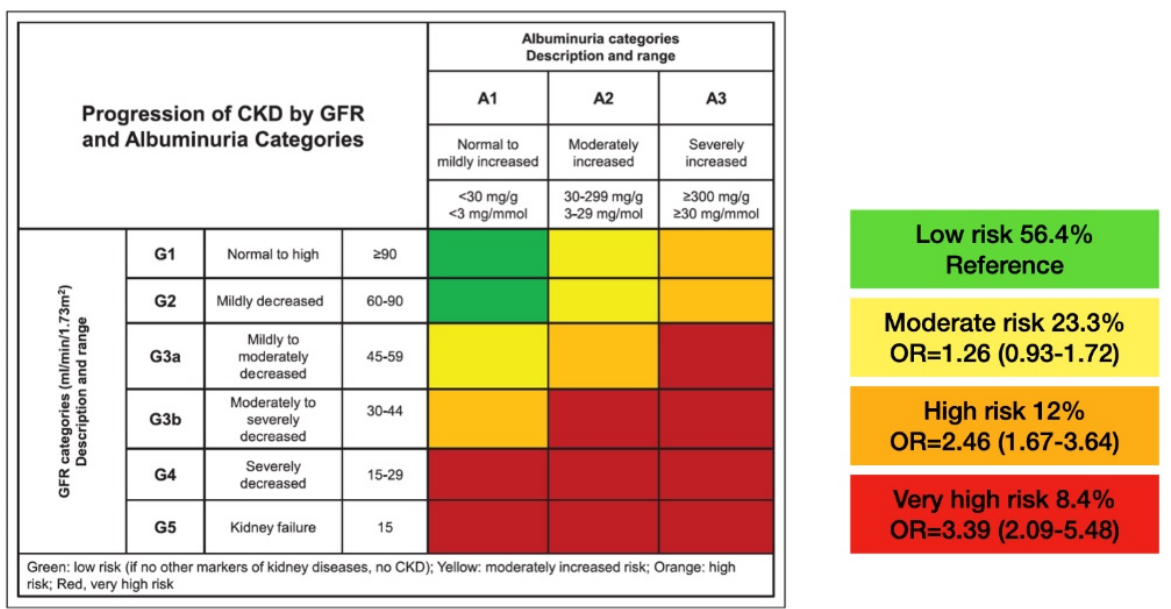
Figure 2. Distribution of the sample into the KDIGO categories and adjusted OR for the risk of having HF at the inclusion visit. CKD: chronic kidney disease; GFR: glomerular filtration rate; G: glomerular filtration rate categories; A: albuminuria categories; OR: odds ratio. Table 3. Independent variables (multivariate analysis) associated with the risk of HF at the inclu- sion visit.